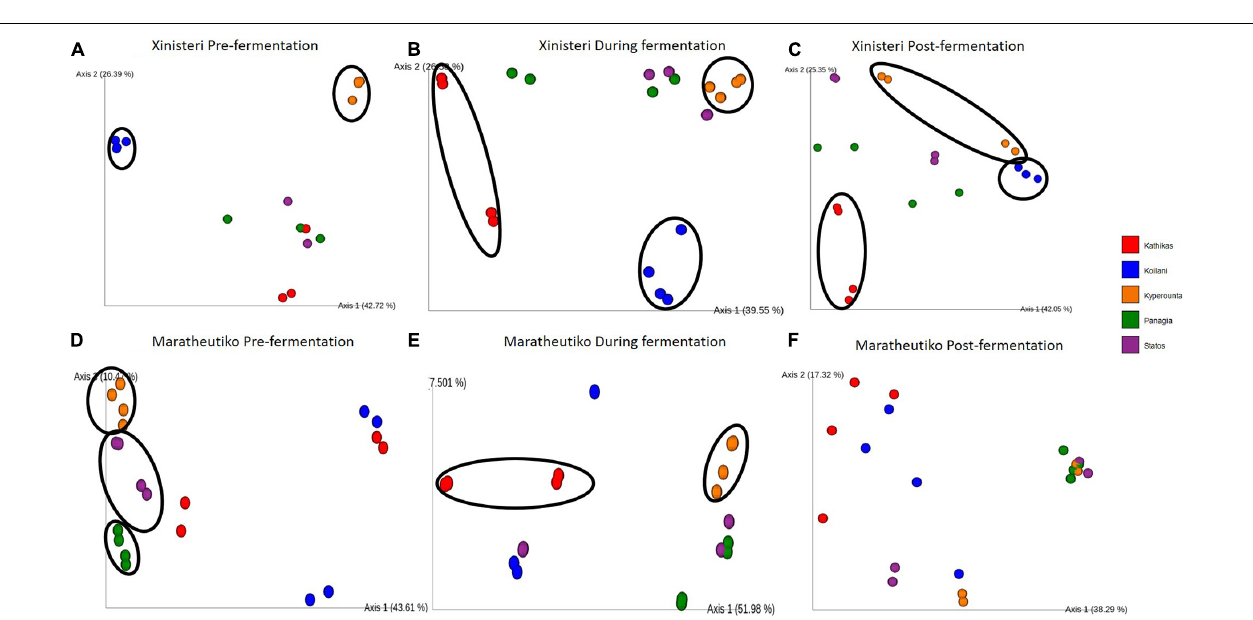
FIGURE 4 | Principal coordinate analysis (PCoA) plot, showing the similarities in the fungal beta diversity according to the Bray-Curtis distance among the individual terroir : (A) for the variety Xynisteri pre-fermentation; (B) for the variety Xynisteri during fermentation; (C) for the variety Xynisteri post-fermentation; (D) for the variety Maratheftiko pre-fermentation; (E) for the variety Maratheftiko during fermentation; (F) for the variety Maratheftiko post-fermentation. Red circles represent Kathikas, blue circles represent Koilani, yellow circles represent Kyperounta, green circles represent Panayia and purple circles represent Statos. Ellipses show the separated terroir